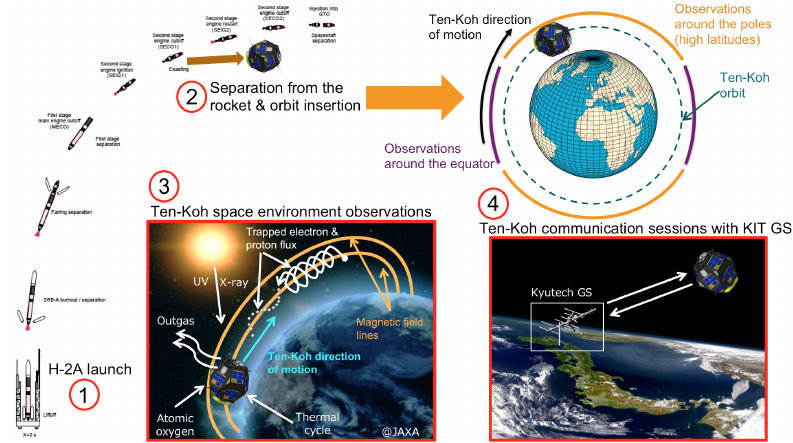
Figure 7. Satellite concept of operations as explained in sequence from 1 to 4. In Processes 3 and 4, a mission is configured to be executed and later payload and housekeeping data are downlinked. This mission configuration–execution–downlinking occurs following the execution of Steps A–D. After launch and when the nominal operations started, only Processes 3 and 4 are present as part of the nominal